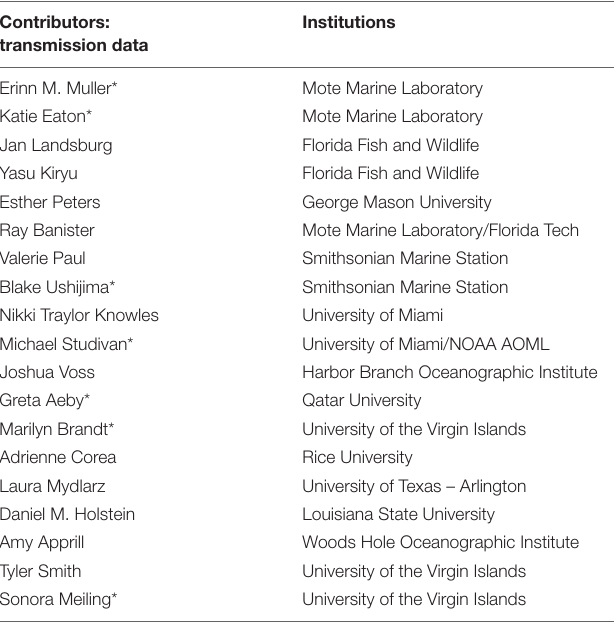
TABLE 2 | Data contributors to the transmission experiments described in section “Transmission Experiments,” to which the calibrated model parameters were